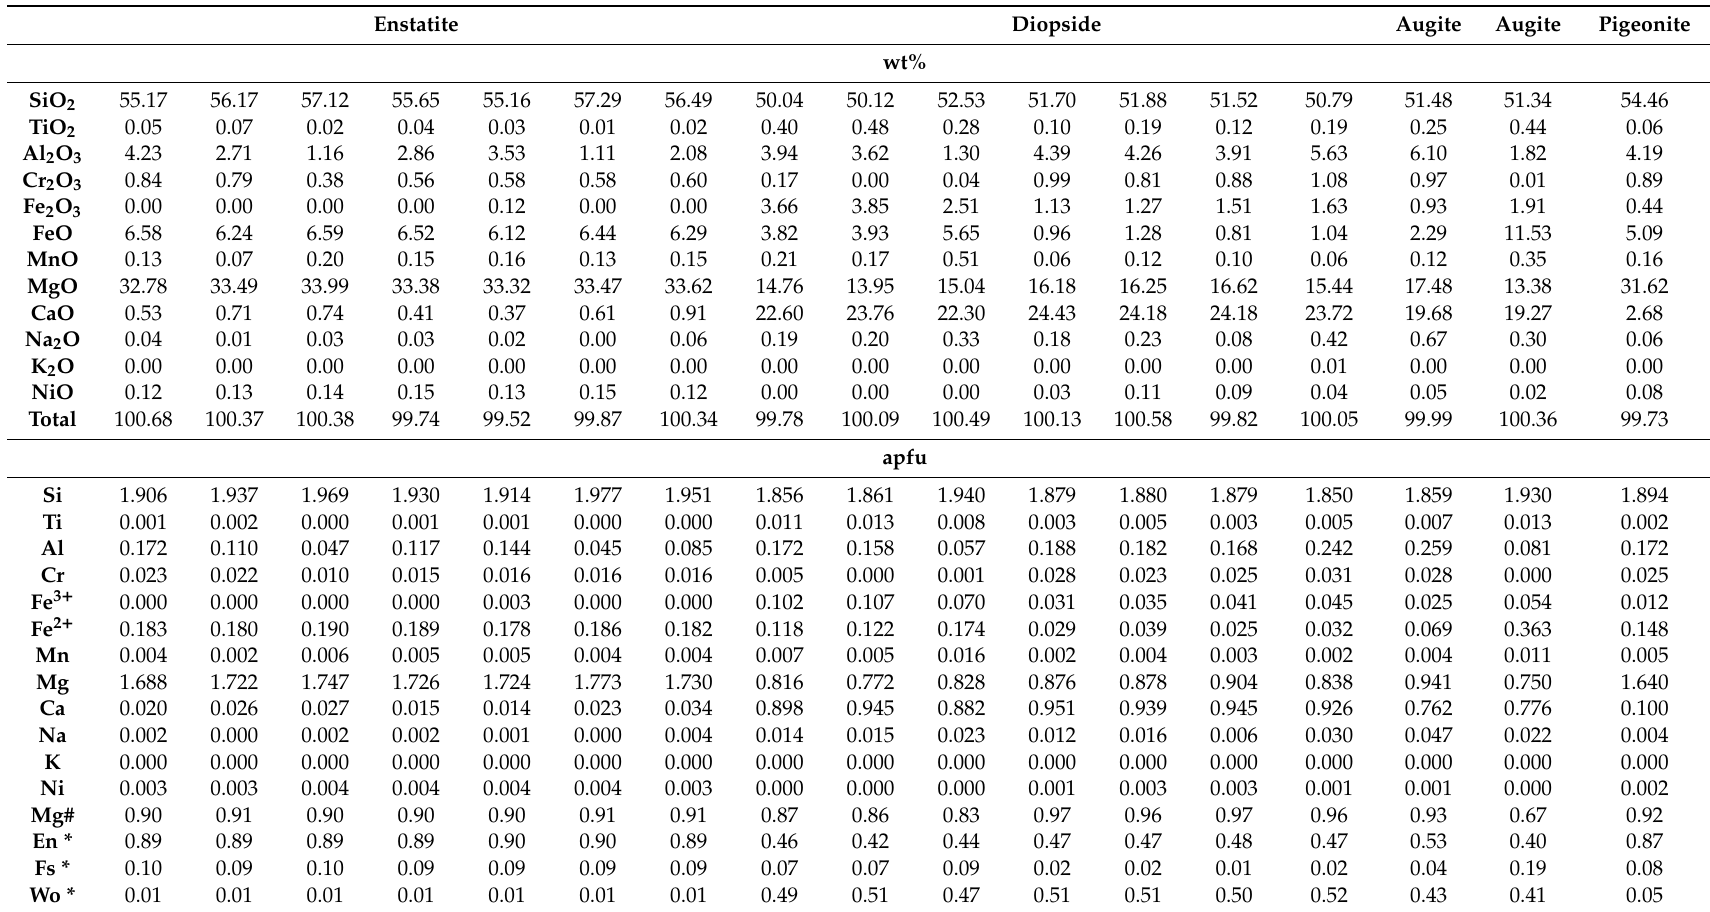
Table 7. Chemical composition of pyroxene in wt%. EPMA